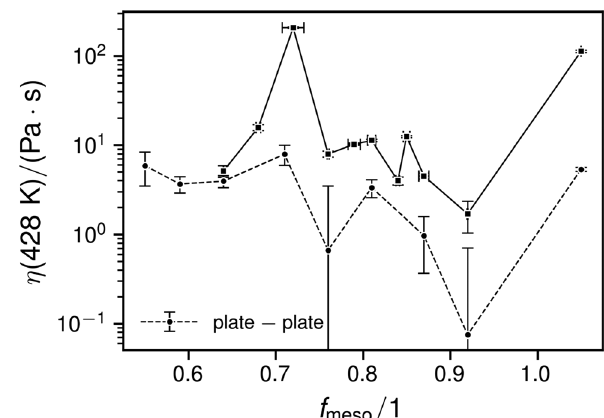
Figure 11: Viscosities calculated from slit data by equation ( 16 ) at −1 = ± ( squares and full lines ) and plate – T 428 = K and γ ˙ 126 8 s w plate data fi ts extrapolated to T 428 = K and γ ˙ ∞ = ( circles and dashed lines ) .